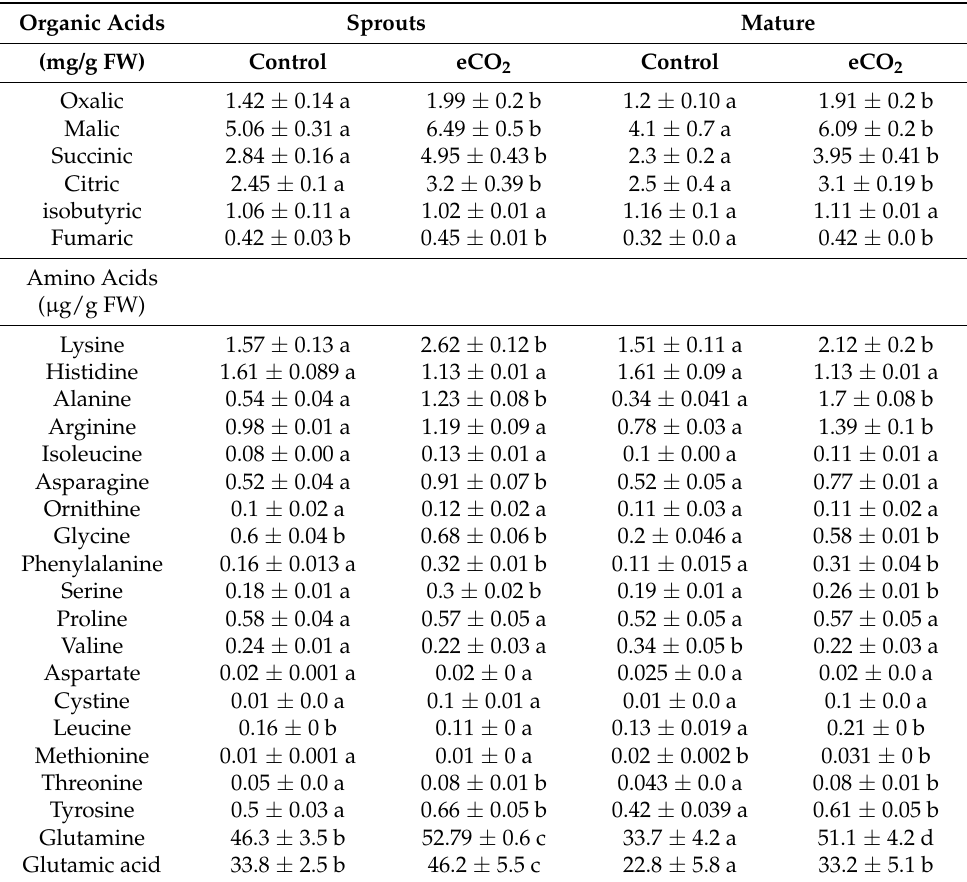
Table 1. Organic acids and amino acids of caraway plants at two developmental stages (sprouts and mature tissues) under control or eCO 2 growth conditions. Data are represented by the means of at least 3 replicates ± standard deviations. Different small letter (a, b, c, and d) within a row indicate significant differences between control and eCO 2 -samples. One-way analysis of variance (ANOVA) was performed. Tukey’s test was used as the post-hoc test for the separation of means ( p <